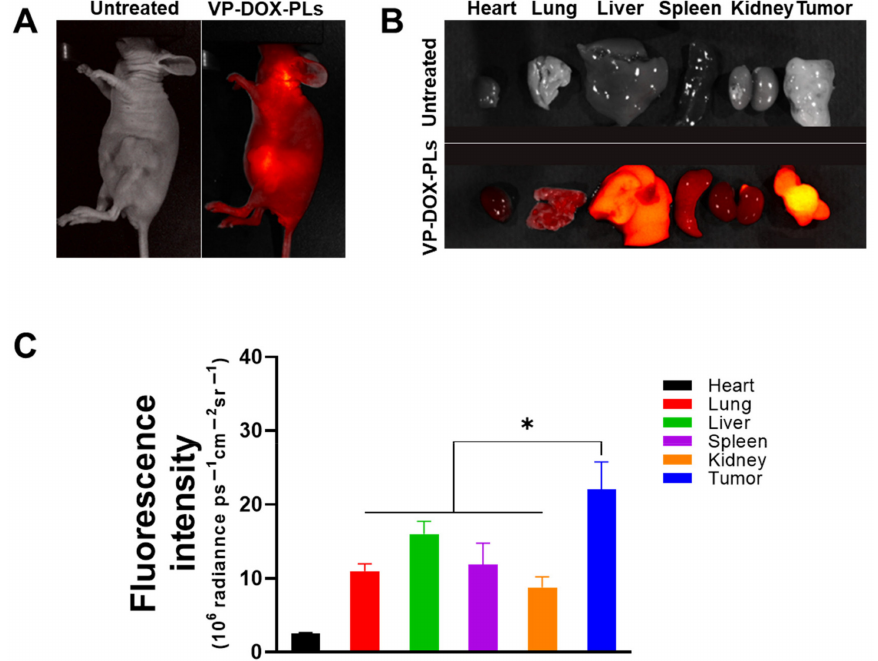
Figure 5. In vivo biodistribution of VP-DOX-PLs in a xenograft tumor model. ( A ) FOBI data of un- treated and VP-DOX-PLs injected intravenously into the mice (Magnification 1.4x). ( B ) Fluorescence images of the major organs from the injected mice (Magnification 1.4x). ( C ) Fluorescence intensities of the major organs and tumor. The significance of the difference between experimental and control groups was determined by Student’s t-test. * p <